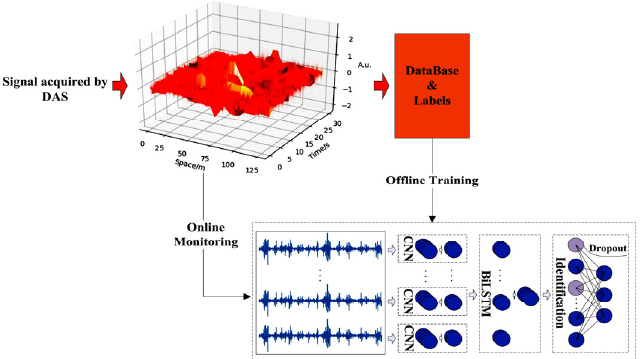
Fig. 37 Proposed 1DCNNs-BiLSTM